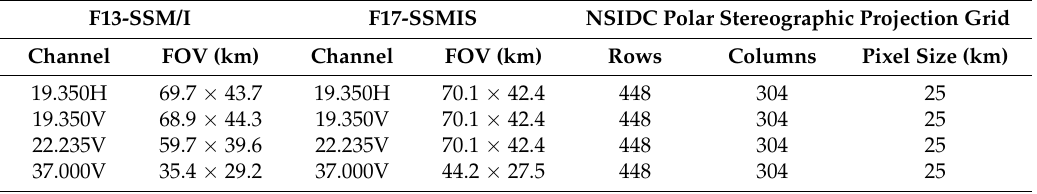
Table 2. Effective field of view (FOV) for SSM/I and SSMIS channels and their resampled grid size.